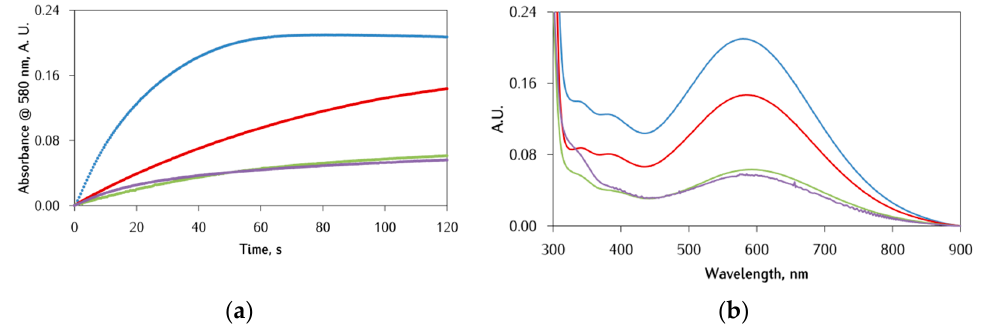
Figure 4. ( a ) Kinetic traces ( λ max = 580 nm) and ( b ) UV-Vis spectra of DA-Fe II (2:1) interaction as a function of peptide concentration in 10 mM Mops bu ff er and 20 mM SDS, pH 7.0, 37 °C, Fe II 0.1 mM, DA 0.2 mM (blue), and 2 equiv. of peptide (Ac- α S 119–132 : red, Ac- α S p S 119–132 : green, Ac- α S p Y p S